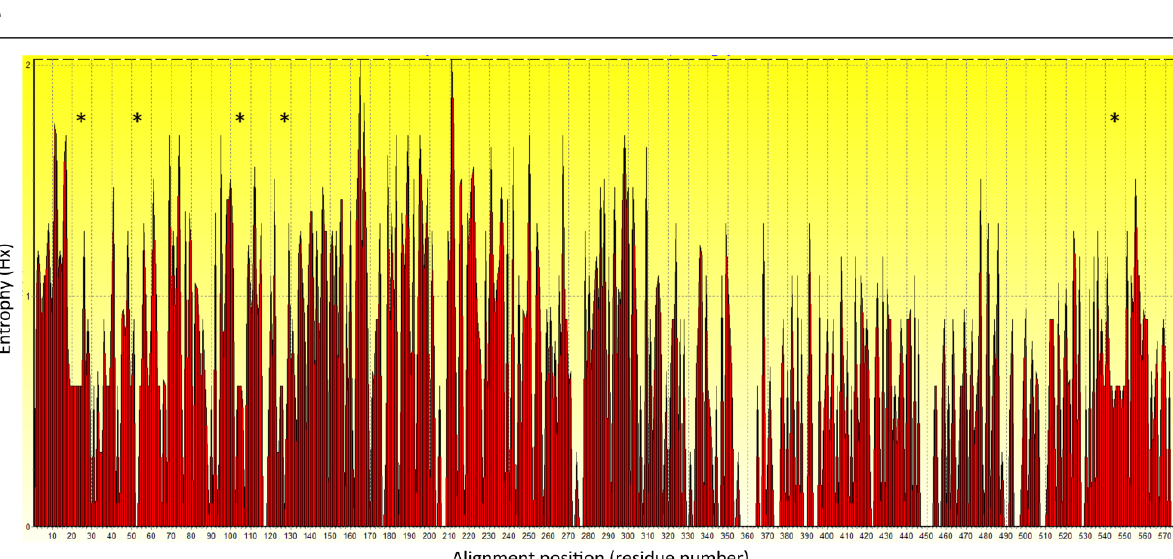
Figure 4. Entropy plot calculated for a large number of influenza HA amino acid sequences. ( A ) Analysis performed on H1, H2, H5, H9 and H3 subtypes. Asterisks indicate several sequence regions differing between influenza phylogenetic group 1 and 2. ( B ) Entropy plot obtained for HA belonging to H5N1